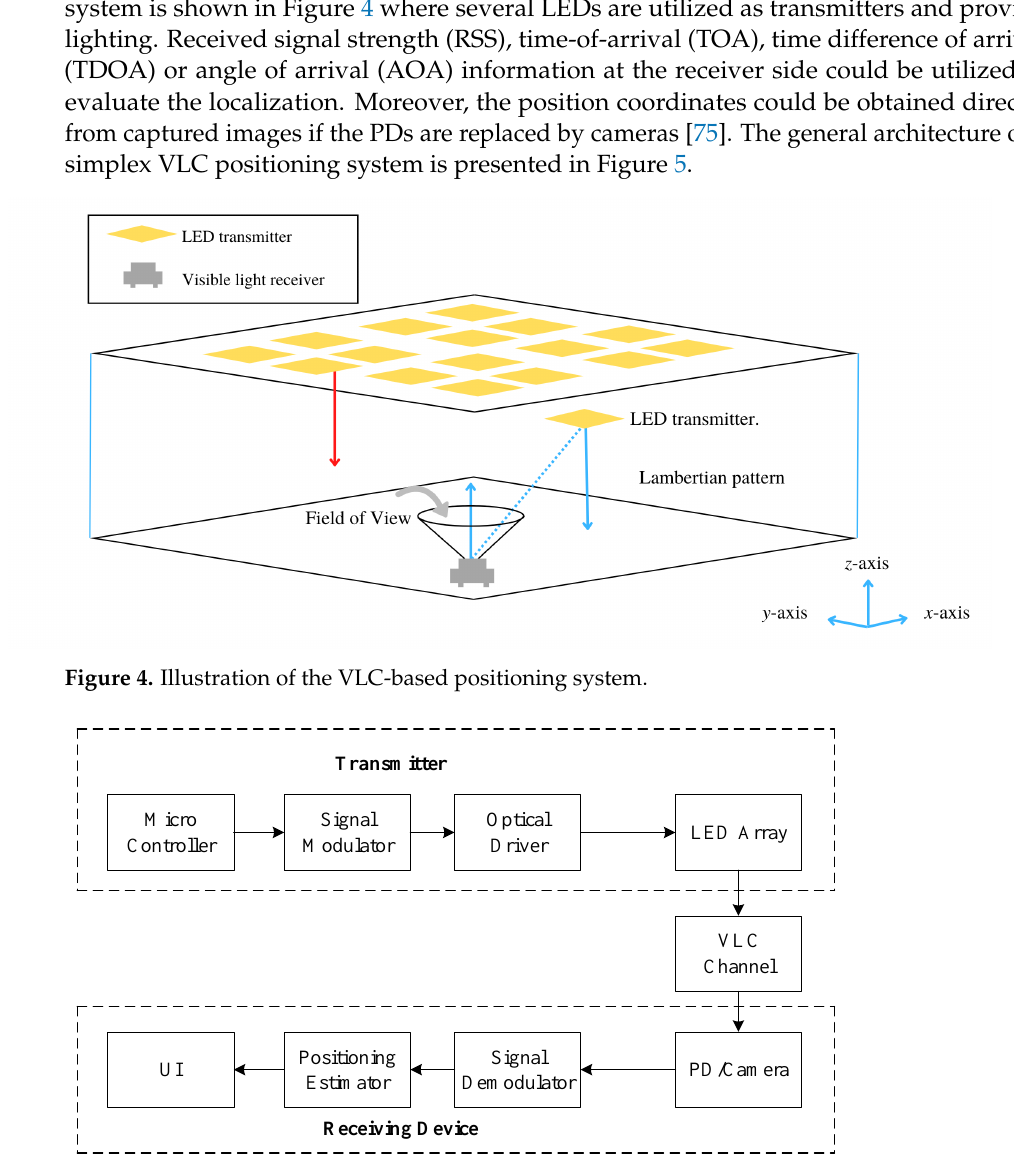
Figure 5. The general architecture of a simplex VLC positioning